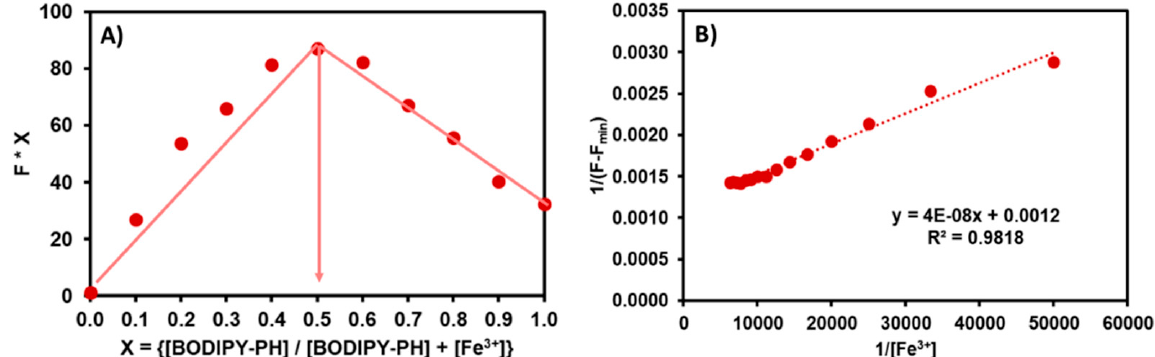
Figure 6. ( A ) Job’s plot for BODIPY-PH in acetonitrile-water (1:9 v / v ). ( B ) Benesi-Hildebrand binding plot generated from the analysis of fluorescence enhancements of BODIPY-PH upon addition of Fe 3+ , and fitted in accordance with Equation (2). Next, the Fe 3+ binding at the pyridylhydrazone (PH) unit was investigated by 1 H NMR spectroscopy. As Fe 3+ is paramagnetic ions that can affect relaxation times of proton- NMR spectra, the NMR resonance frequency of protons close to Fe 3+ binding unit could be altered upon binding [52]. As displayed in Figure 7, the hydrazone proton signal (H 4 ) at 8.06 ppm completely disappeared and the amine proton resonance (H 5 ) at 10.98 ppm almost completely disappeared upon the addition of Fe 3+ . The rest of the proton peaks of pyridylhydrazone moiety became broader indicating that Fe 3+ bound to the PH unit which is consistent with the previous findings [25,53,54]. In addition, the detections of molecular ions at m/z = 639.0923 {[(BODIPY-PH-H)Fe(NO 3 )(DMSO)] + } and 684.0762 {[(BODIPY-PH- H)Fe(NO 3 )(DMSO)(EtOH)] from electrospray ionization mass spectra (ESI-MS) confirmed the existence of iron-BODIPY complex (Figure S4).